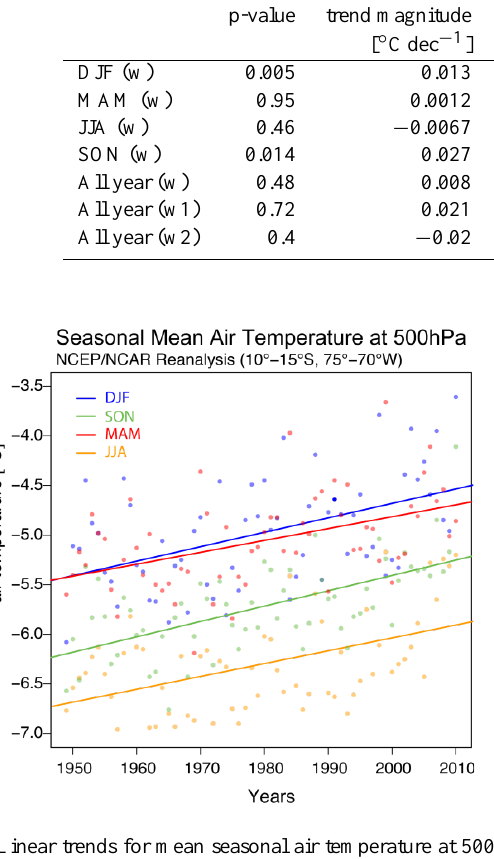
Figure 6. Linear trends for mean seasonal air temperature at 500 hPa level from NCEP/NCAR 2 Fig. 6. Linear trends for mean seasonal air temperature at 500hPa Reanalysis for the period 1958-2009. Dashed trend lines indicate where the p-value is above 3 level from NCEP/NCAR Reanalysis for the period 1958–2009. Dashed trend lines indicate where the p-value is above the signif- the significance level 0.005 (cf. Table 6). 4 icance level 0.05 (cf. Table 6).